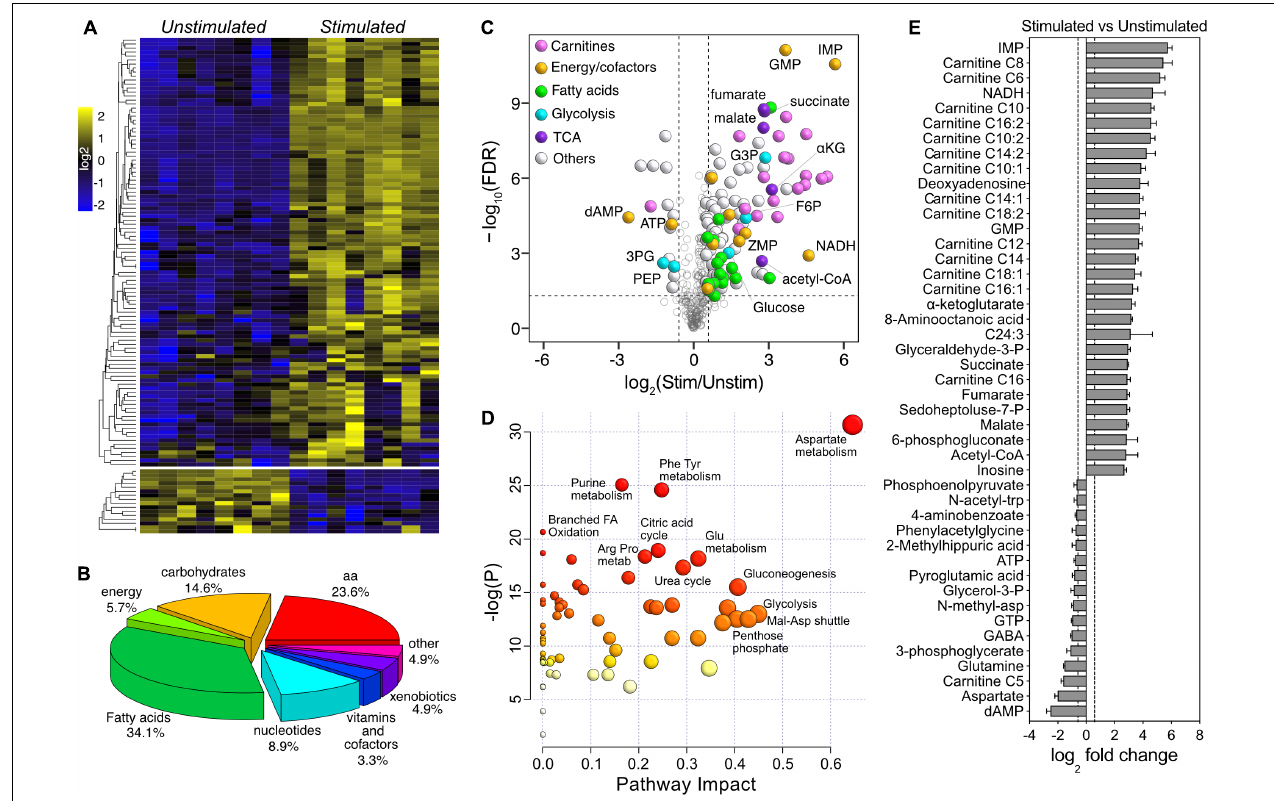
FIGURE 4 | Univariate analysis of the effect of moderate exercise. (A) Heatmap of log 2 -transformed, row-wise normalized intensities for metabolites with FDR-adjusted P < 0.05 and fold change > ± 1.5 (123 of 321). (B) Pie chart representation of the metabolite superclasses significantly affected by stimulation. (C) Volcano plot showing the effect of stimulation. The dotted horizontal line represents the significance threshold (ANOVA, FDR-adjusted P ≤ 0.05, n = 8), while the dotted vertical lines represent the fold change cut-off ( ± 1.5). Significant data points are color-coded according to the different superclasses. (D) Pathway impact analysis of metabolites differentially regulated upon stimulation. The node color is based on the P -values from pathway enrichment ( y- axis), while the size is proportional to the pathway impact value ( x -axis). (E) Ranked representation of the 45 most differentially regulated metabolites upon stimulation ( n = 8).